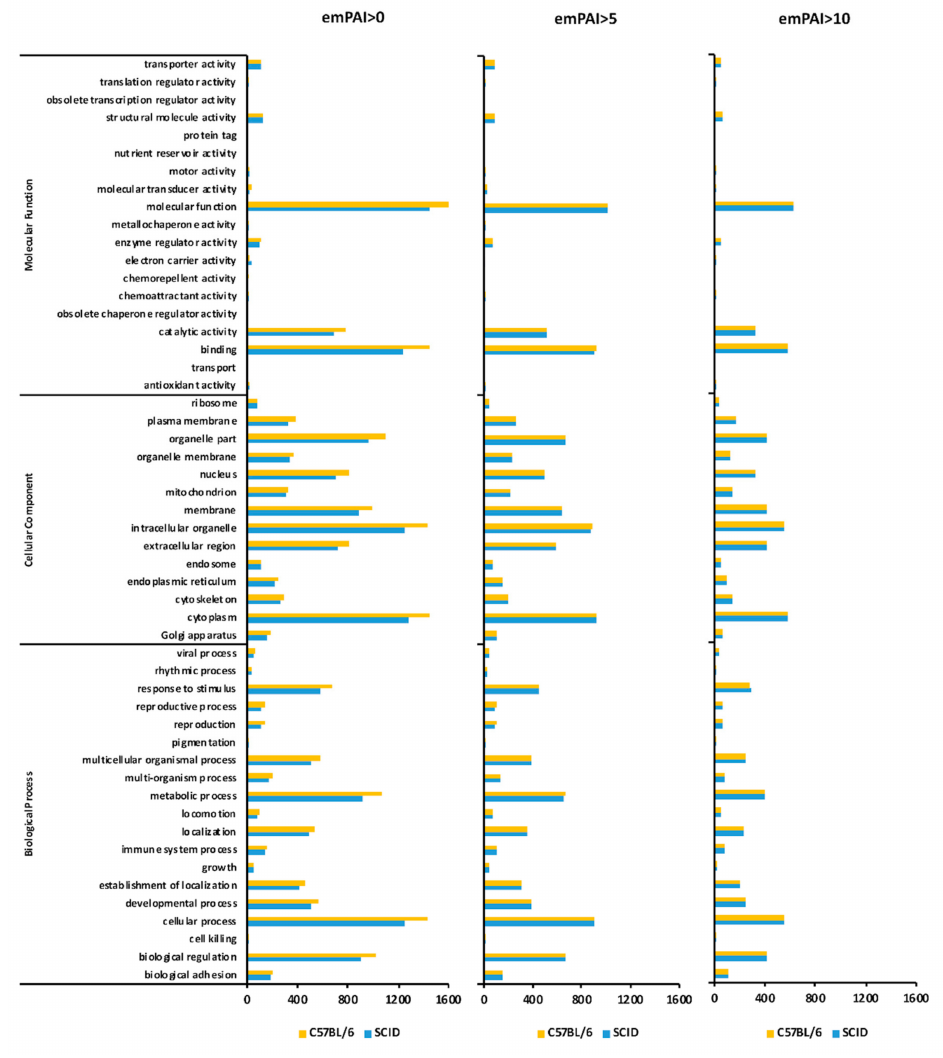
Figure 3. GO analysis of proteins expressed by C57BL / 6 mAdMSCs and SCID mAdMSCs. The left, center, and right panels indicate the number of proteins expressed by cultured C57BL / 6 and SCID mAdMSCs with emPAI > 0, > 5, and > 10, respectively. The proteins classified in Supplementary Tables S3, S5–S8 are listed according to the GO categories as follows: growth, immune system